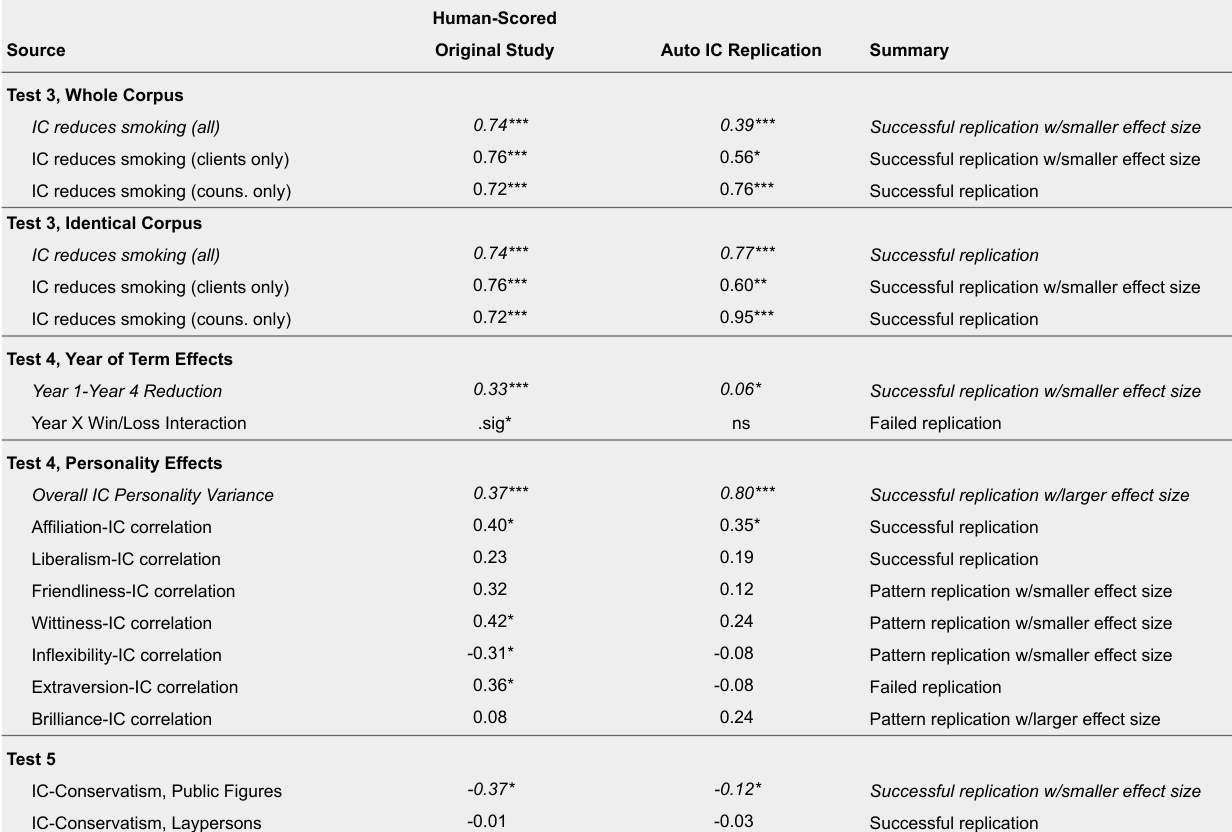
Replication Comparison Effect Sizes and Inferential Statistics from Validity Tests 3-5